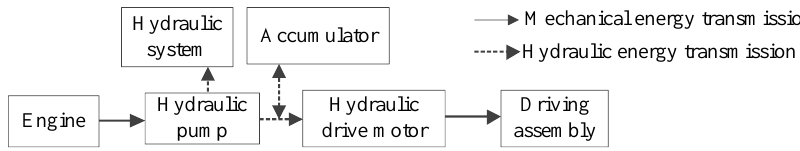
Figure 4. Typical configuration of series oil–hydraulic hybrid system [26,27].